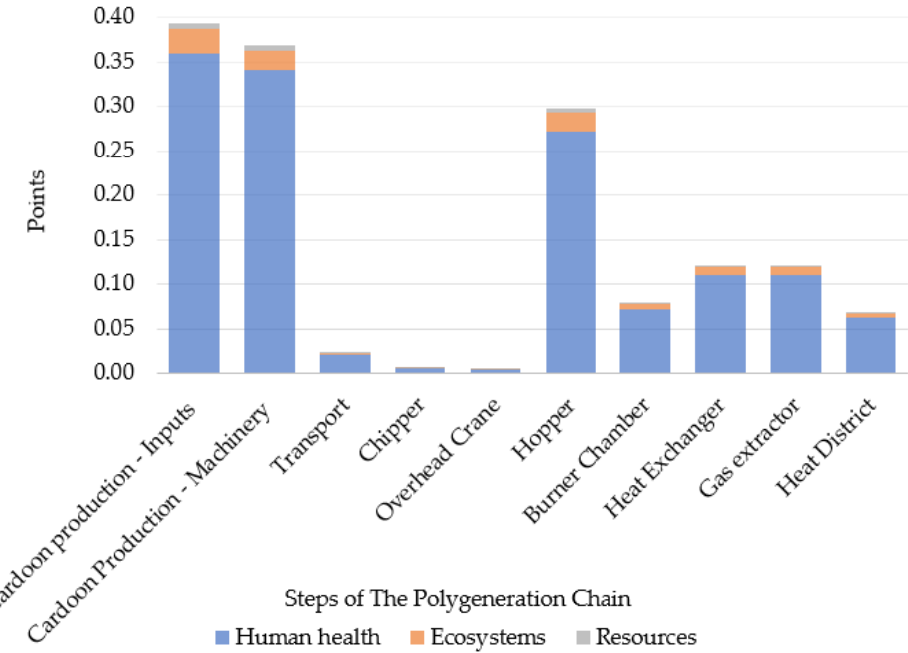
Figure 6. ReCiPe endpoint—single point—polygeneration chain.